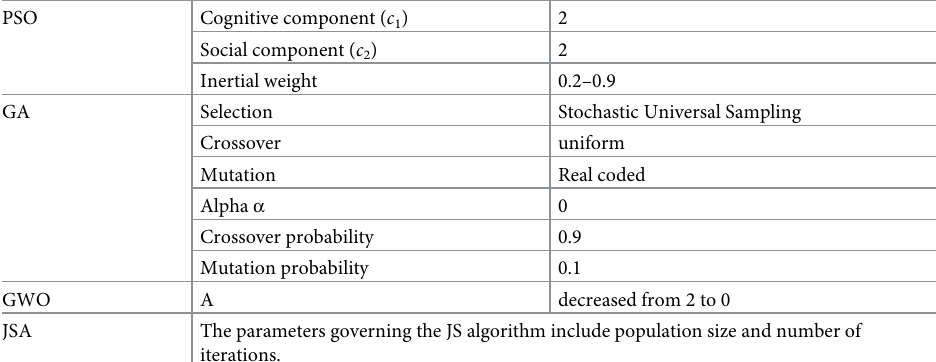
Table 4. Private parameter settings of each metaheuristic optimization algorithm.